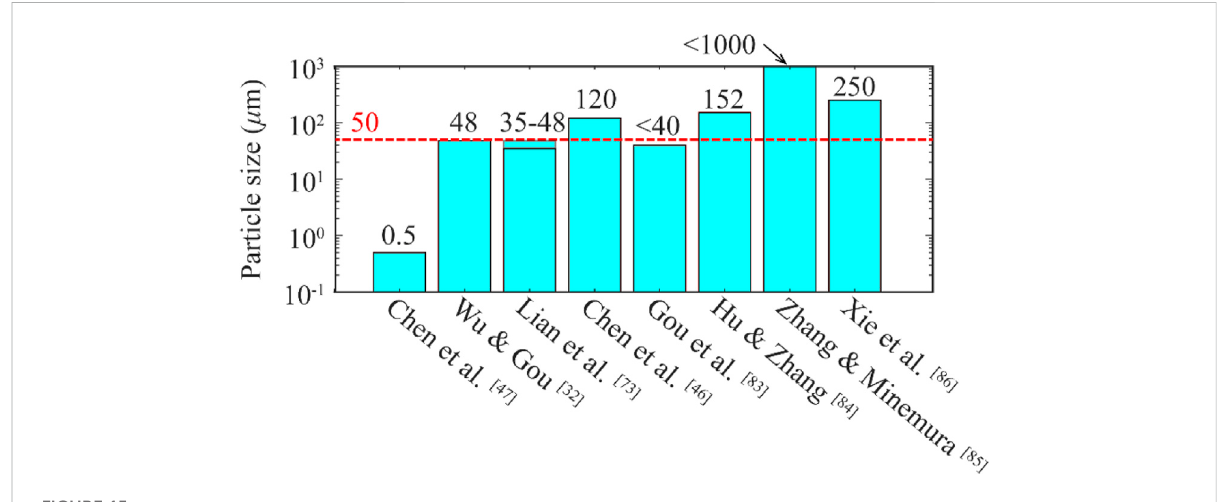
FIGURE 15 Critical sediment particle size in the